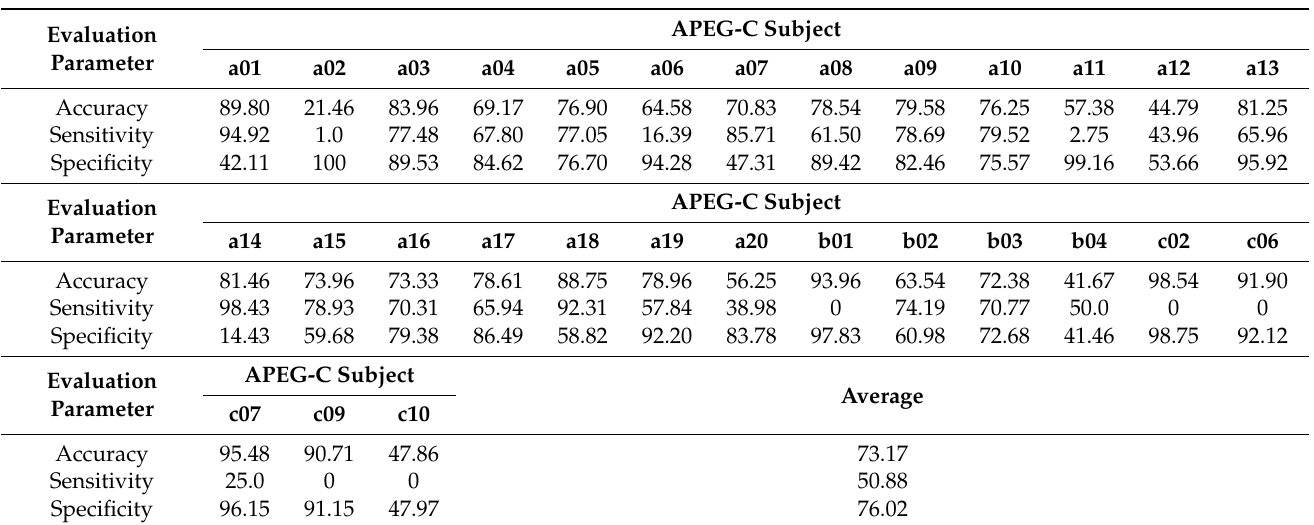
Table 10. Leave-one-subject-out cross-validation classification performance using a PAED-APEG-C 60 s time window based on 8~50 Hz frequency range and SVM